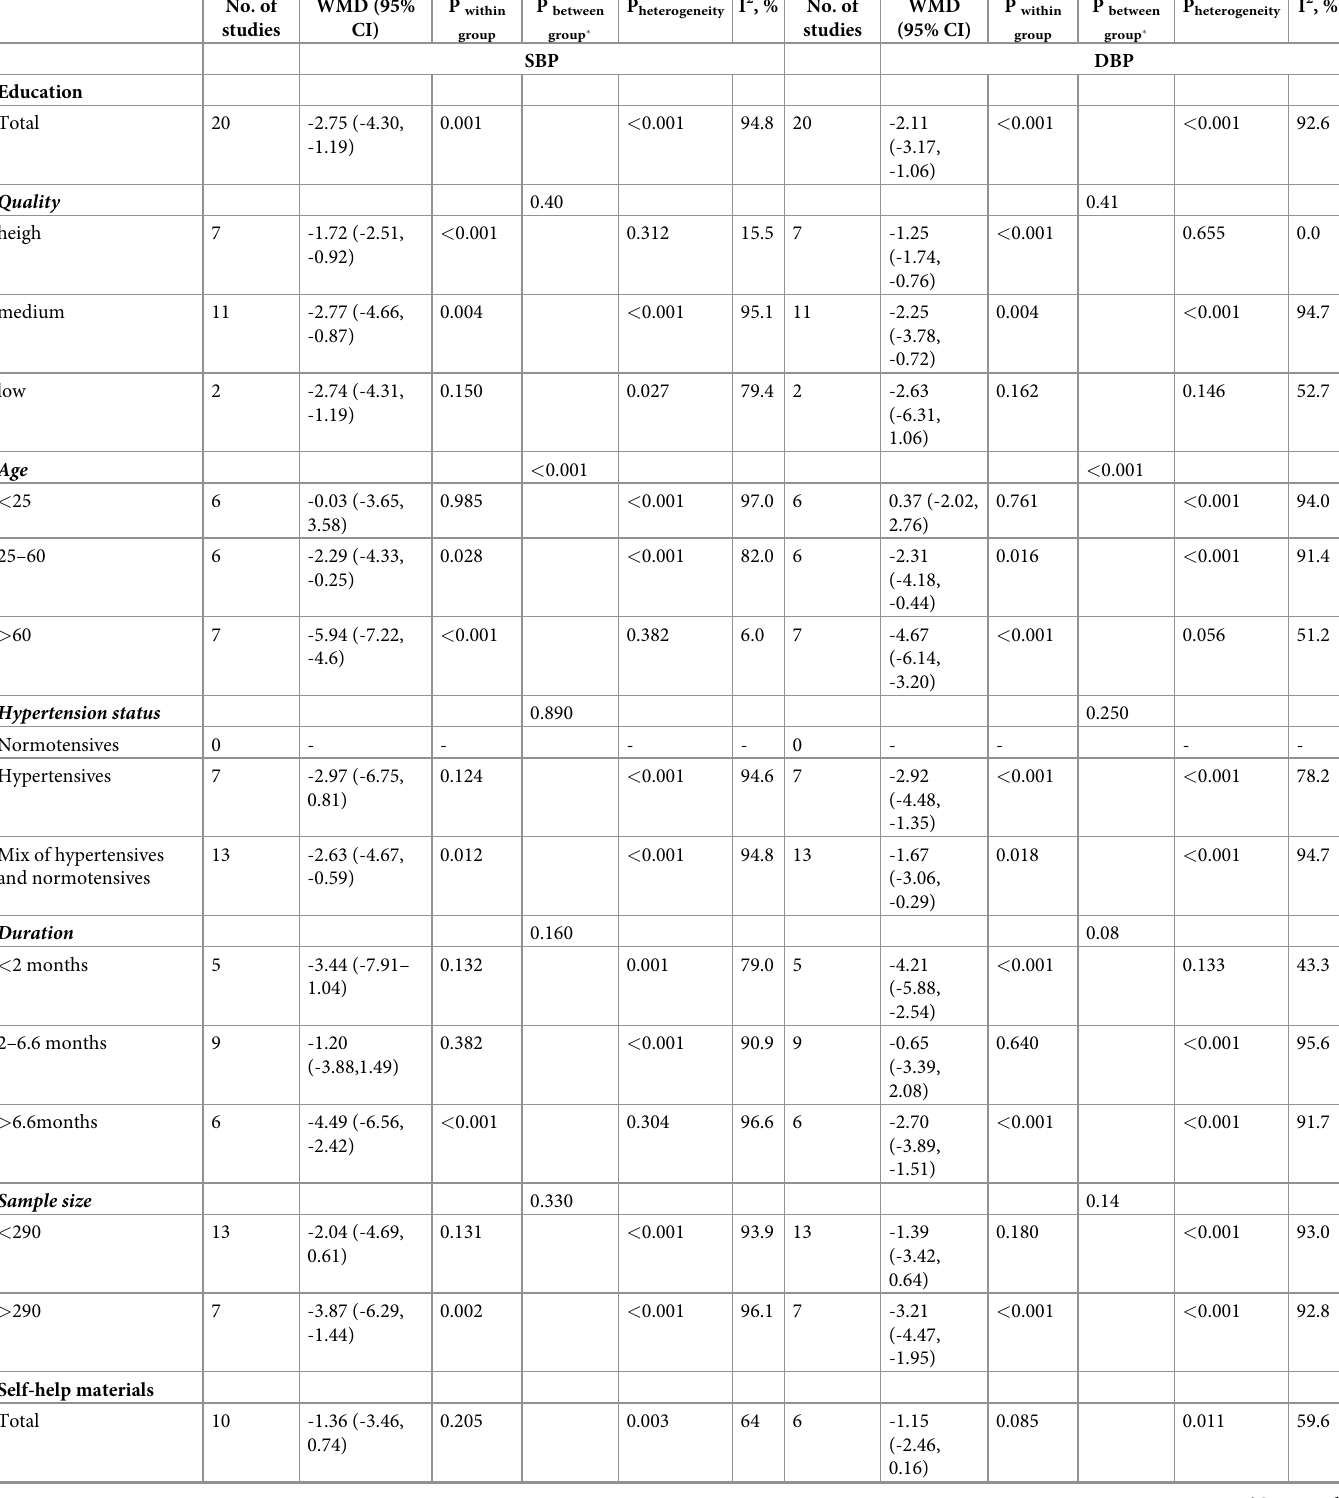
Table 3. Results of subgroup analyses according to study or participant